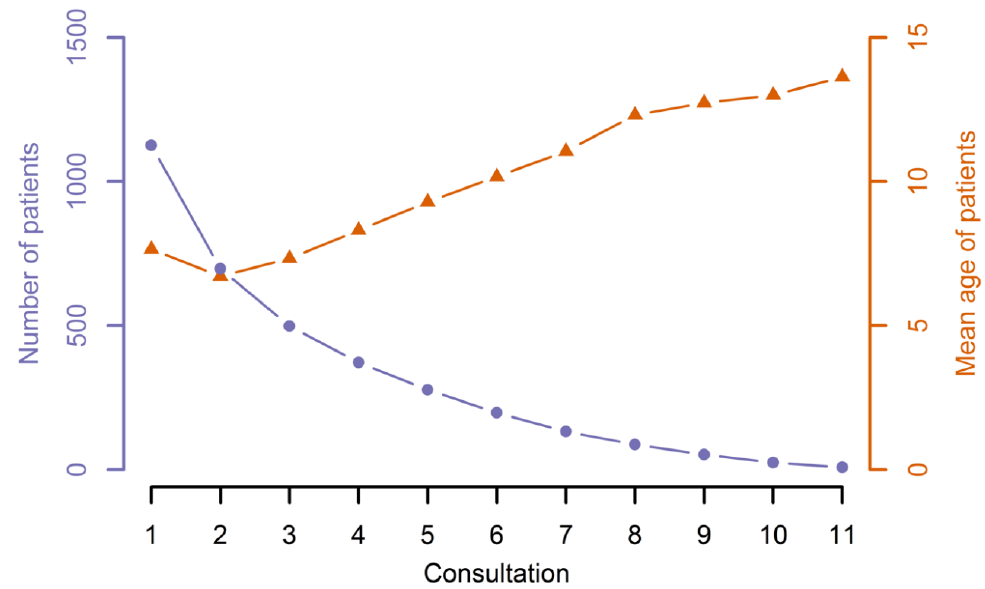
Figure 1. Follow-up visits of all patients within the observation period. The number of patients and their mean age according to the number of total consultations, which varied between 1 and 11, are shown.